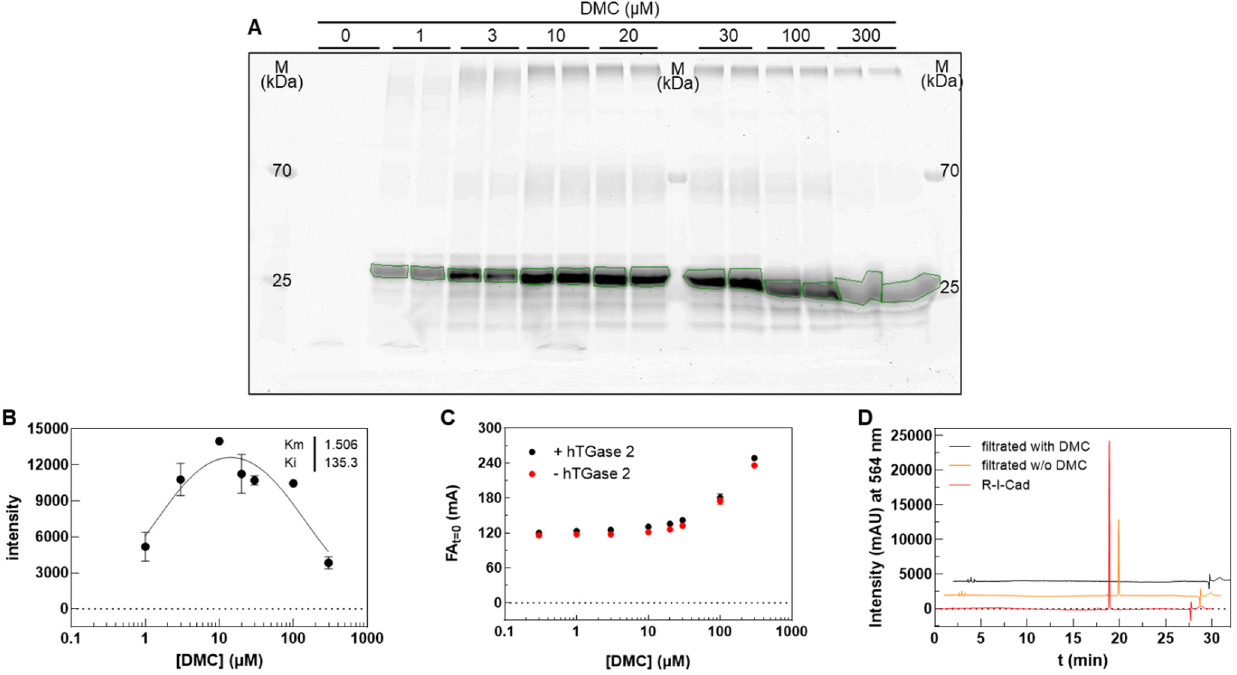
Figure 2. Elucidation of the underlying mechanism for the decreased product formation at high DMC concentrations. ( A ) Visualization of R-I-Cad -labeled DMC at varying DMC concentrations after separation of the reaction mixtures (one gel, each DMC concentration in duplicate, conditions as described in Figure 1 but with 2.5 µg/mL hTGase 2) with SDS-PAGE and detection by in-gel fluorescence readout (Cy3 filter of Amersham Typhoon 5 biomolecular imager). Regions bordered in green were quantified for the plot in ( B ). The 25 and 70 kDa orange-stained proteins of the Thermo Scientific™ PageRuler™ Plus Prestained Protein Ladder were made visible by the fluorescence readout. ( B ) Plot of Intensity (DMC bands in ( A ), mean values ± SD) versus DMC concentration with nonlinear regression using Equation (2). ( C ) Plot of the FA values (mean values ± SEM of two separate experiments, each performed in duplicate) at start of measurement versus DMC concentration. The data were obtained during the characterization of DMC on hTGase 2 previously published by us [54]. ( D ) Analytical RP-HPLC chromatograms at 564 nm for a solution of R-I-Cad in MOPS buffer (8.1 µ M, 5 µ L analyzed, red) and after filtration (15,000 × g , 90 min) of this solution using centrifugal concentrators (polyethersulfone membrane, molecular weight cut-off of 3 kDa) in the absence (20 µ L analyzed, orange) and presence (20 µ L analyzed, black) of DMC (300 µ